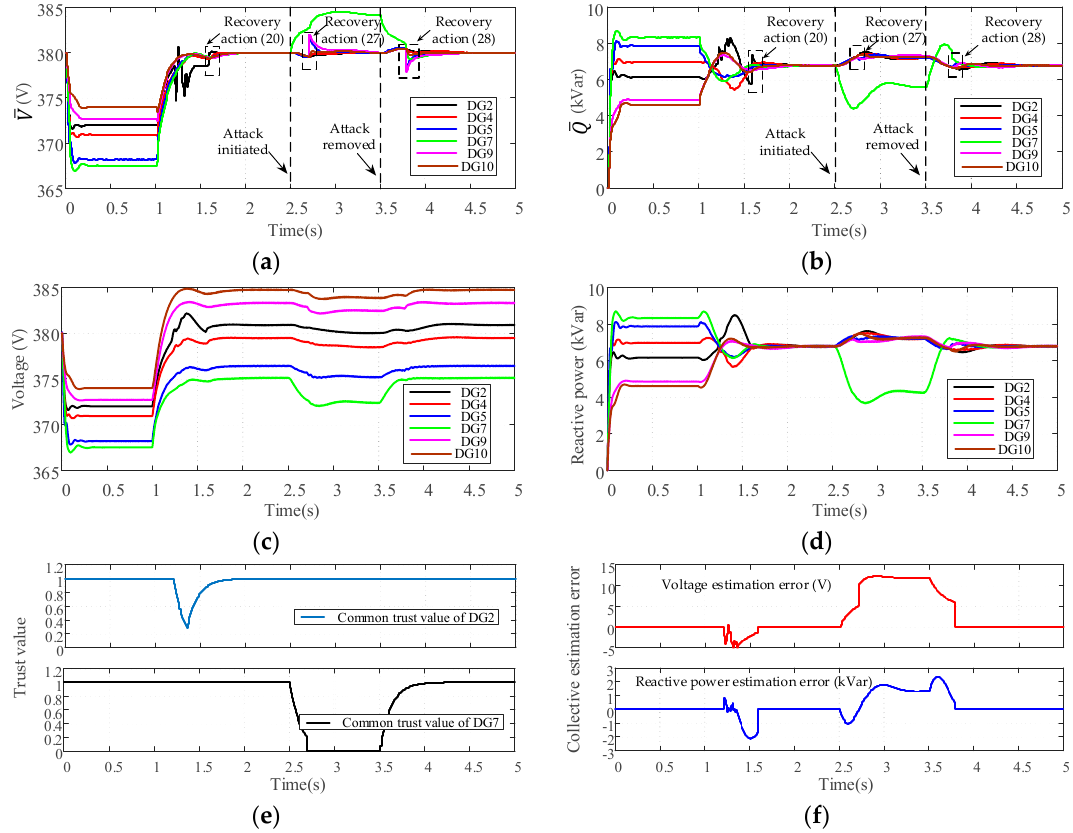
Figure 15. Performance of the control scheme under the scalability test: ( a ) Average voltage estimates; ( b ) Average reactive power estimates; ( c ) Voltages of DGs; ( d ) Reactive power of DGs. ( e ) Common trust values of DG2 and DG7; ( f ) Collective estimation error.